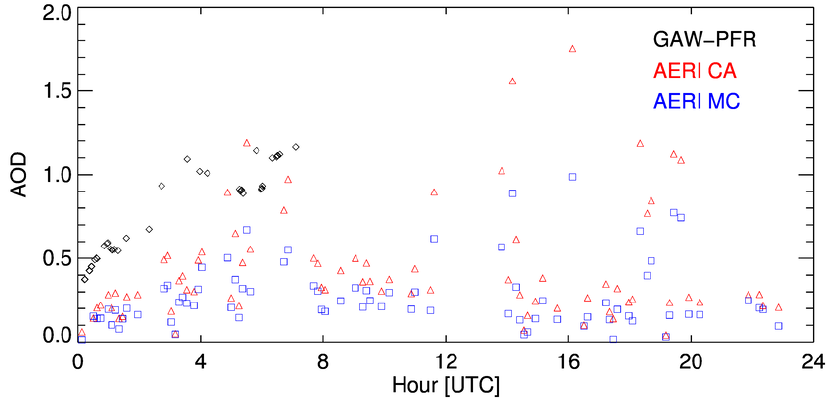
Figure 10. The time series of the retrieved AOD assuming different aerosol types, CA (red triangle) and MC (blue square), and that observed (black, diamond) using GAW-PFR. and MC (blue square), and that observed (black, diamond) using